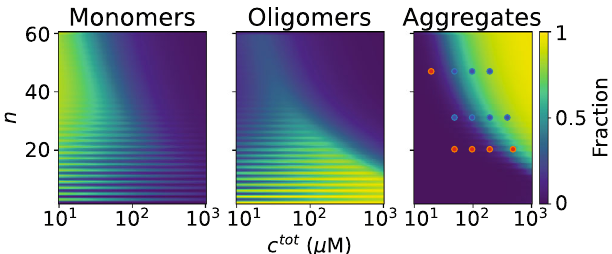
Fig. 3| LandscapeofCAG repeats. The equilibrium fractionofstrandsfolded into monomers,oligomers(2 – 4-mers;primarilydimers),andaggregatesareshownand compared to Nguyen et al. ’ s molecular dynamics (MD) simulation results. As the same sticker strength, with no fi tting parameters to the simulations